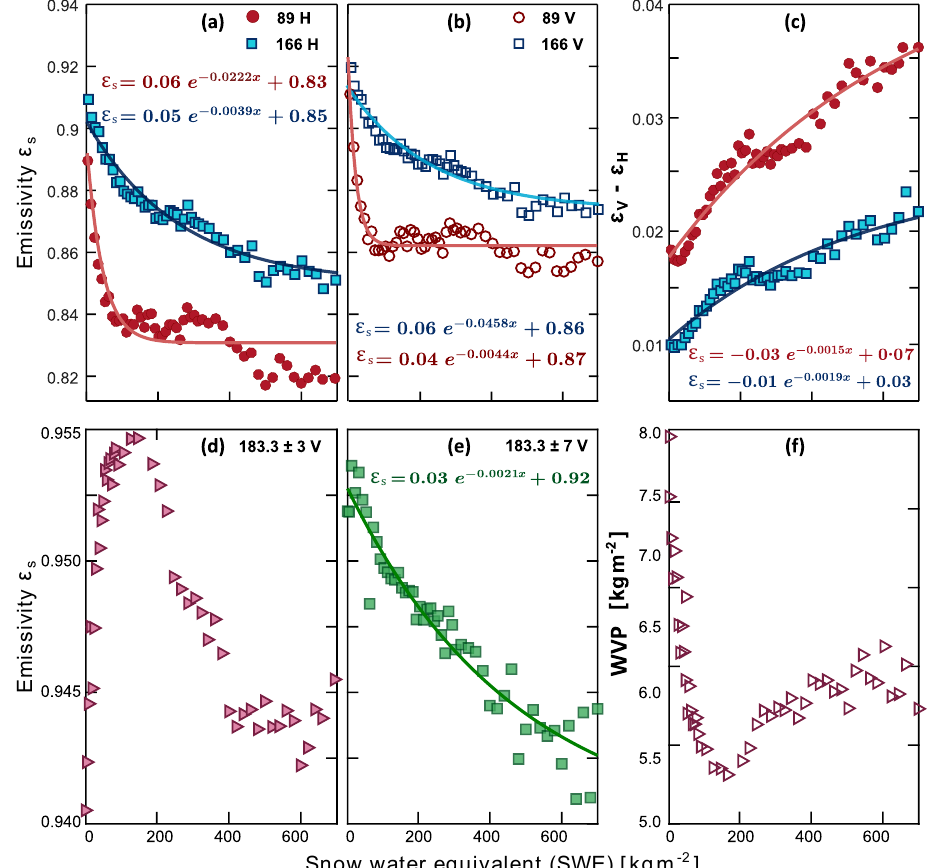
Figure 4. Clear-sky emissivity with snow water equivalent at GPM high-frequency channels (89 H and 166 H ( a ), 89 V and 166 V ( b ), 183 ± 3 ( d ), and 183 ± 7 ( e )), the emissivity differences of V-pol and H-pol at 89 and 166 GHz frequencies ( c ), and the corresponding WVP ( f ). Note that the total cloud liquid water path, integrated total precipitable water, and ice water path in the column of atmosphere and the near-surface precipitation are all zeros based on the data from both MERRA-2 model simulations and the DPR ancillary database